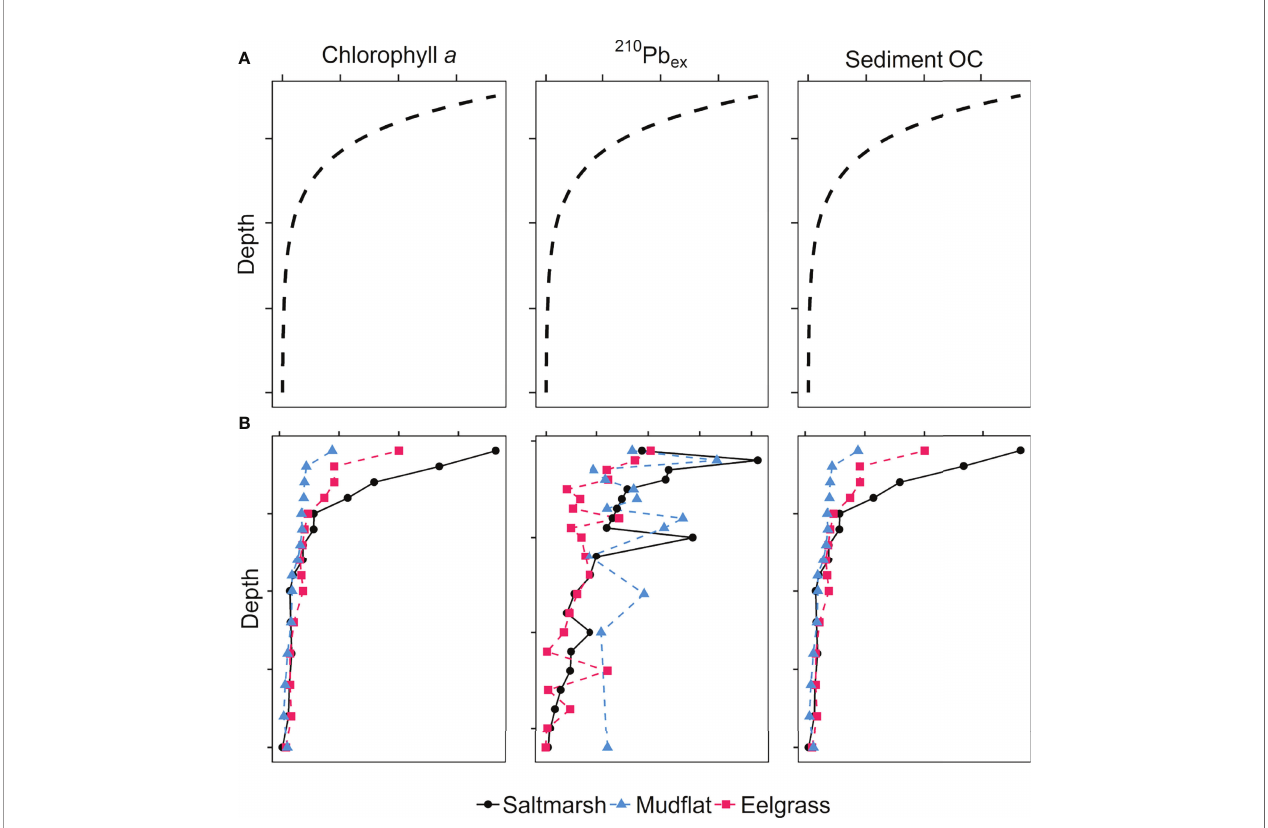
FIGURE 8 | In fl uence of hydrodynamic sediment mixing and relative rates of decay on pro fi les of chlorophyll a , excess 210 Pb, and bulk sediment organic carbon (OC) in deposited sediments in an intertidal system. Panel (A) shows idealized depth pro fi les with steady-state sediment accumulation where hydrodynamic mixing is minimal, resulting in exponential decay of (1) chlorophyll a followed by (2) excess 210 Pb and (3) organic matter decomposition; Panel (B) shows typical depth pro fi les in a system like the Cowichan Estuary where physical mixing is strong on unvegetated mud fl ats (dashed blue pro fi les), and dampened increasingly by eelgrass (dashed red pro fi les) and salt marsh vegetation (solid black pro fi